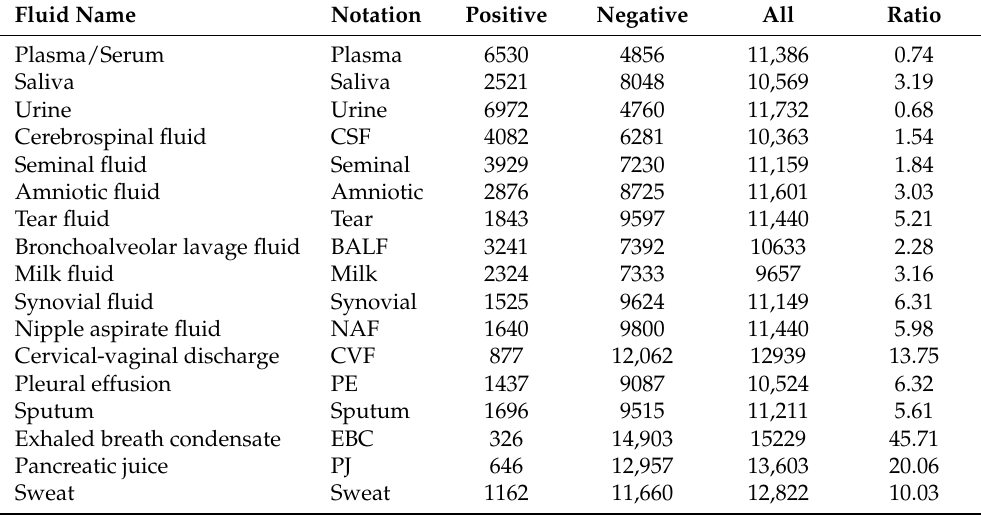
Table 1. The numbers of proteins and the ratio of positive and negative samples in each human body fluid of the SecretedP17